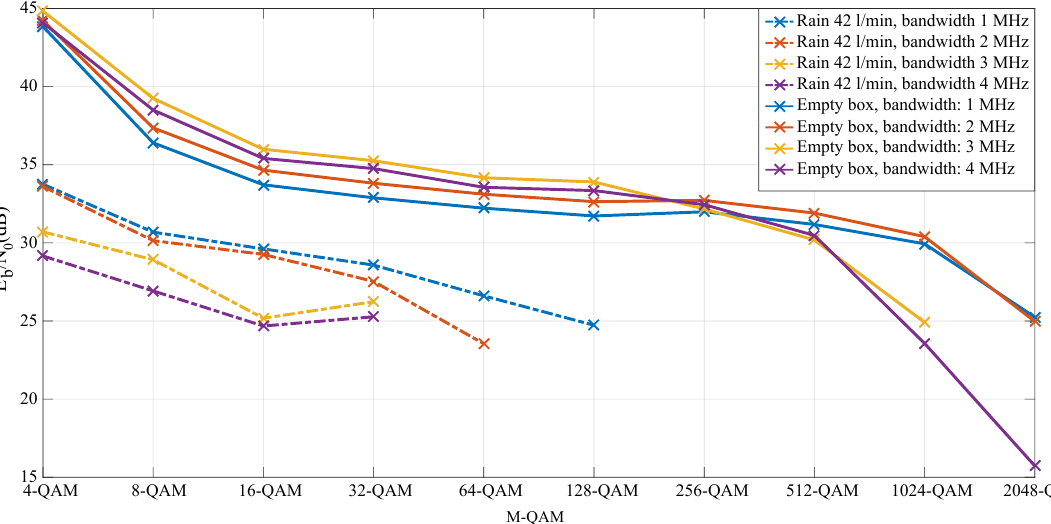
Figure 25. E b /N 0 / distance relationship for Octavia tail-light with different M-QAM and bandwidths —scenario 3—Rain 42 L/min.